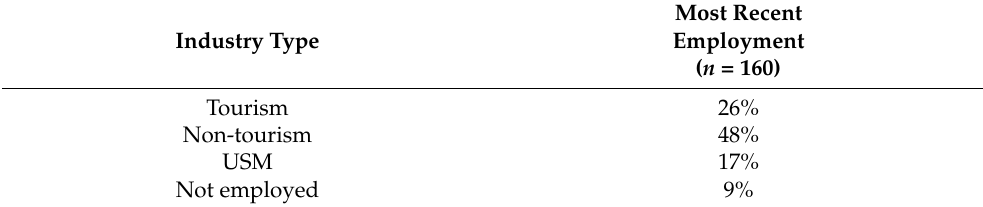
Table 3. Most recent employment industry type.